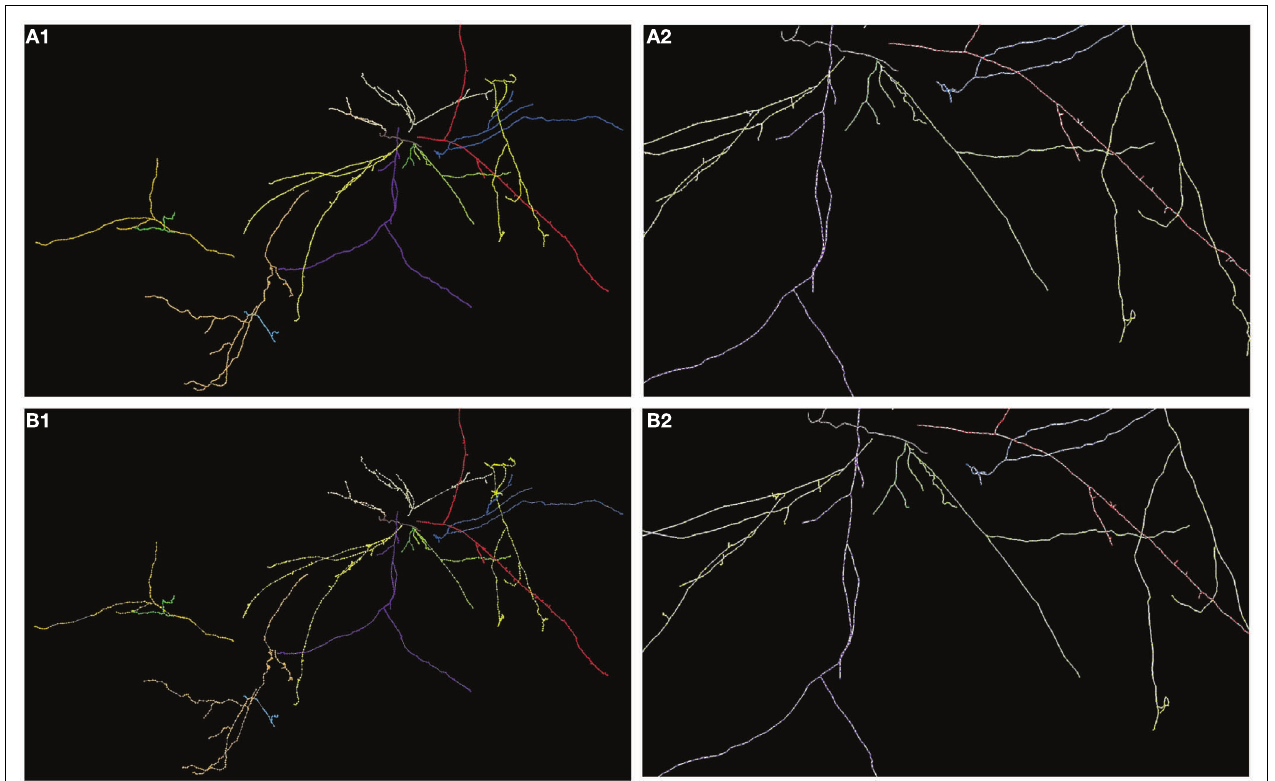
FIGURE 12 | (A) Maximum intensity projection of hippocampal CA3 (each color represents a different tree; each tree was reconstructed separately) with superimposed reconstruction (A1) and zoomed fragment (A2) . (B) Ground truth (B1) and (B2) .